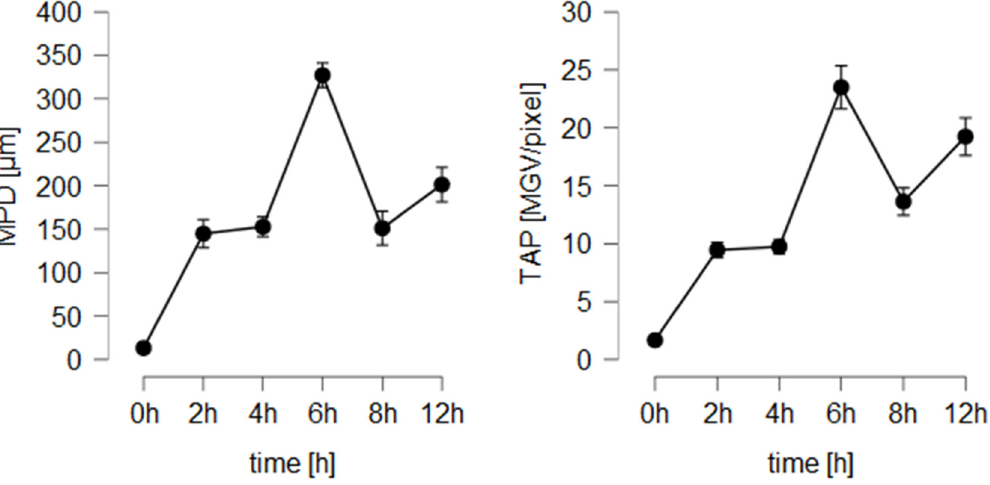
Figure 9. Influence of penetration time on penetration efficacy of curcumin from smartFilms.